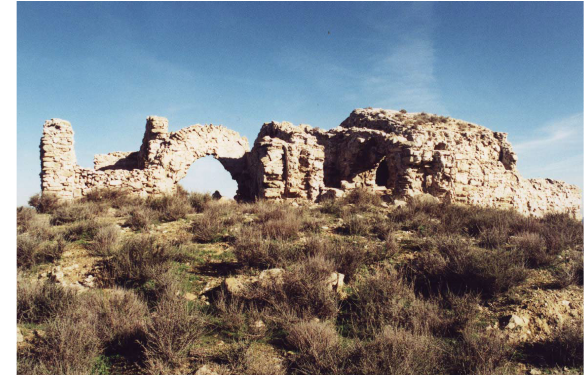
Figure 5. View of Santa Cruz Hermitage Ruins (Perdiguera).